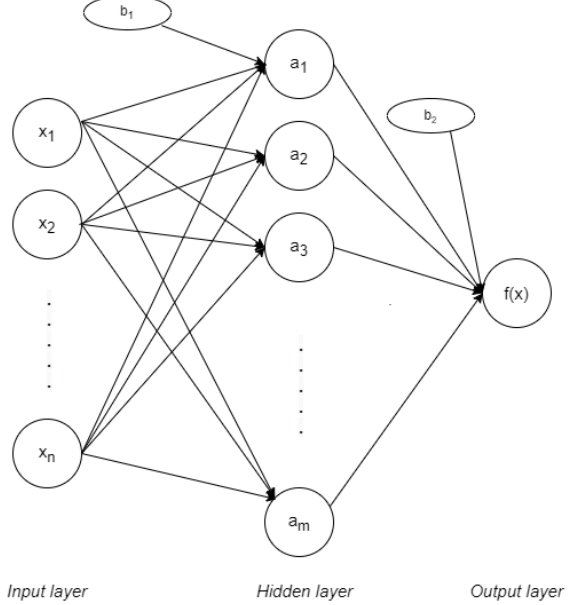
Figure 3. Multilayer Perceptron (MLP) with one hidden